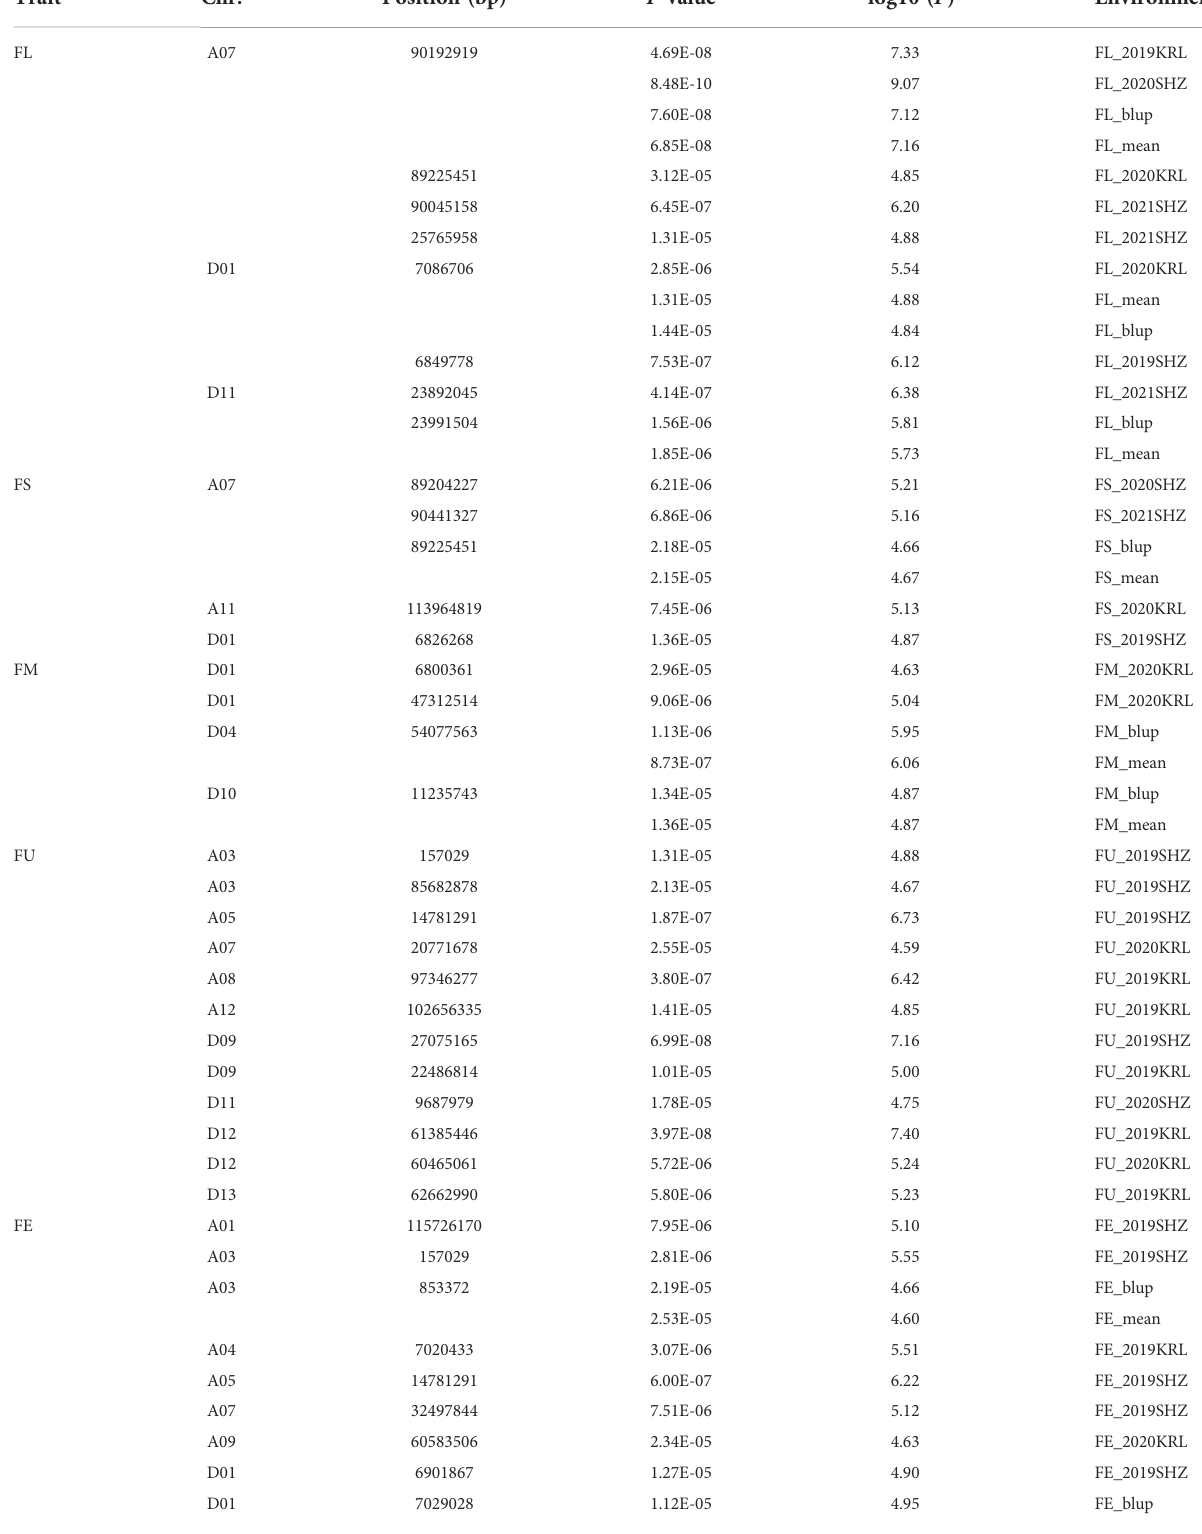
TABLE 3 Single-nucleotide polymorphic loci associated with fi ber quality traits. Trait Chr. Position (bp) P -value − log10 ( P